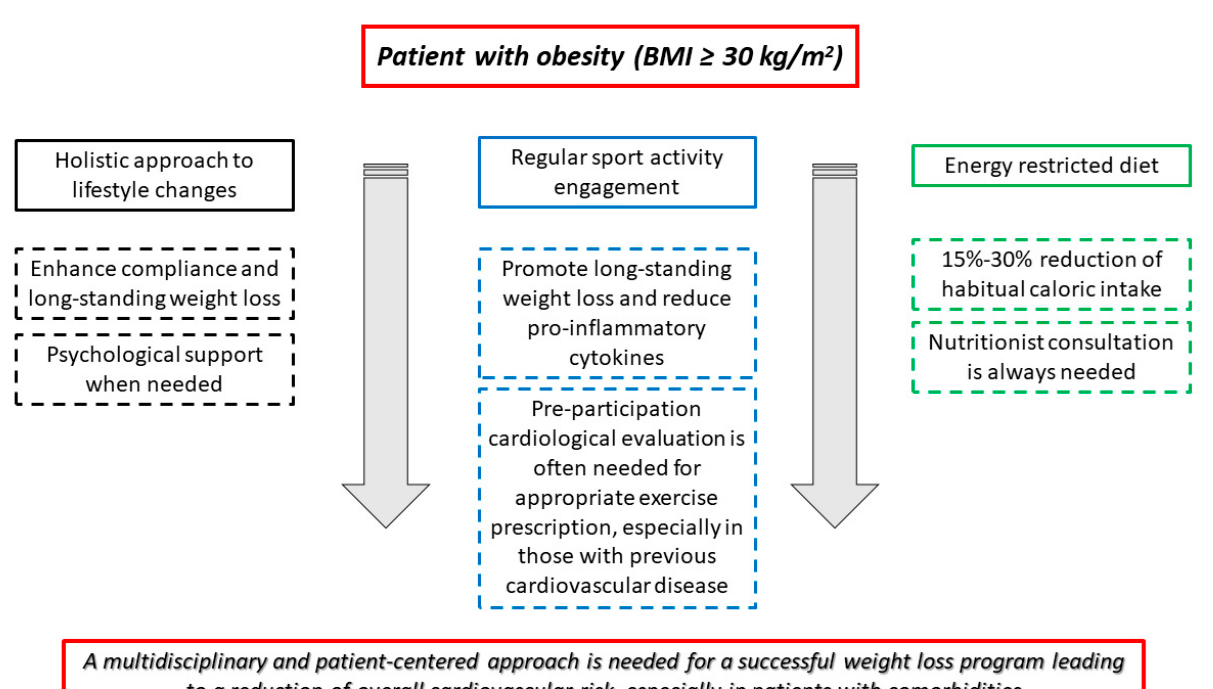
Figure 2. A multidisciplinary and patient-centered approach is needed for a successful weight loss program. Lifestyle changes, dietary restriction, and physical activity equally contribute to effective and long-term weight